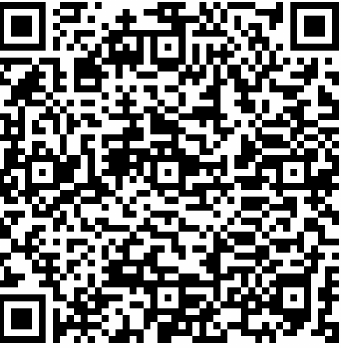
Figure 3 Please scan this QRCODE to access the interactive visualization (Ruhi Sipahioğlu et al., 2021)